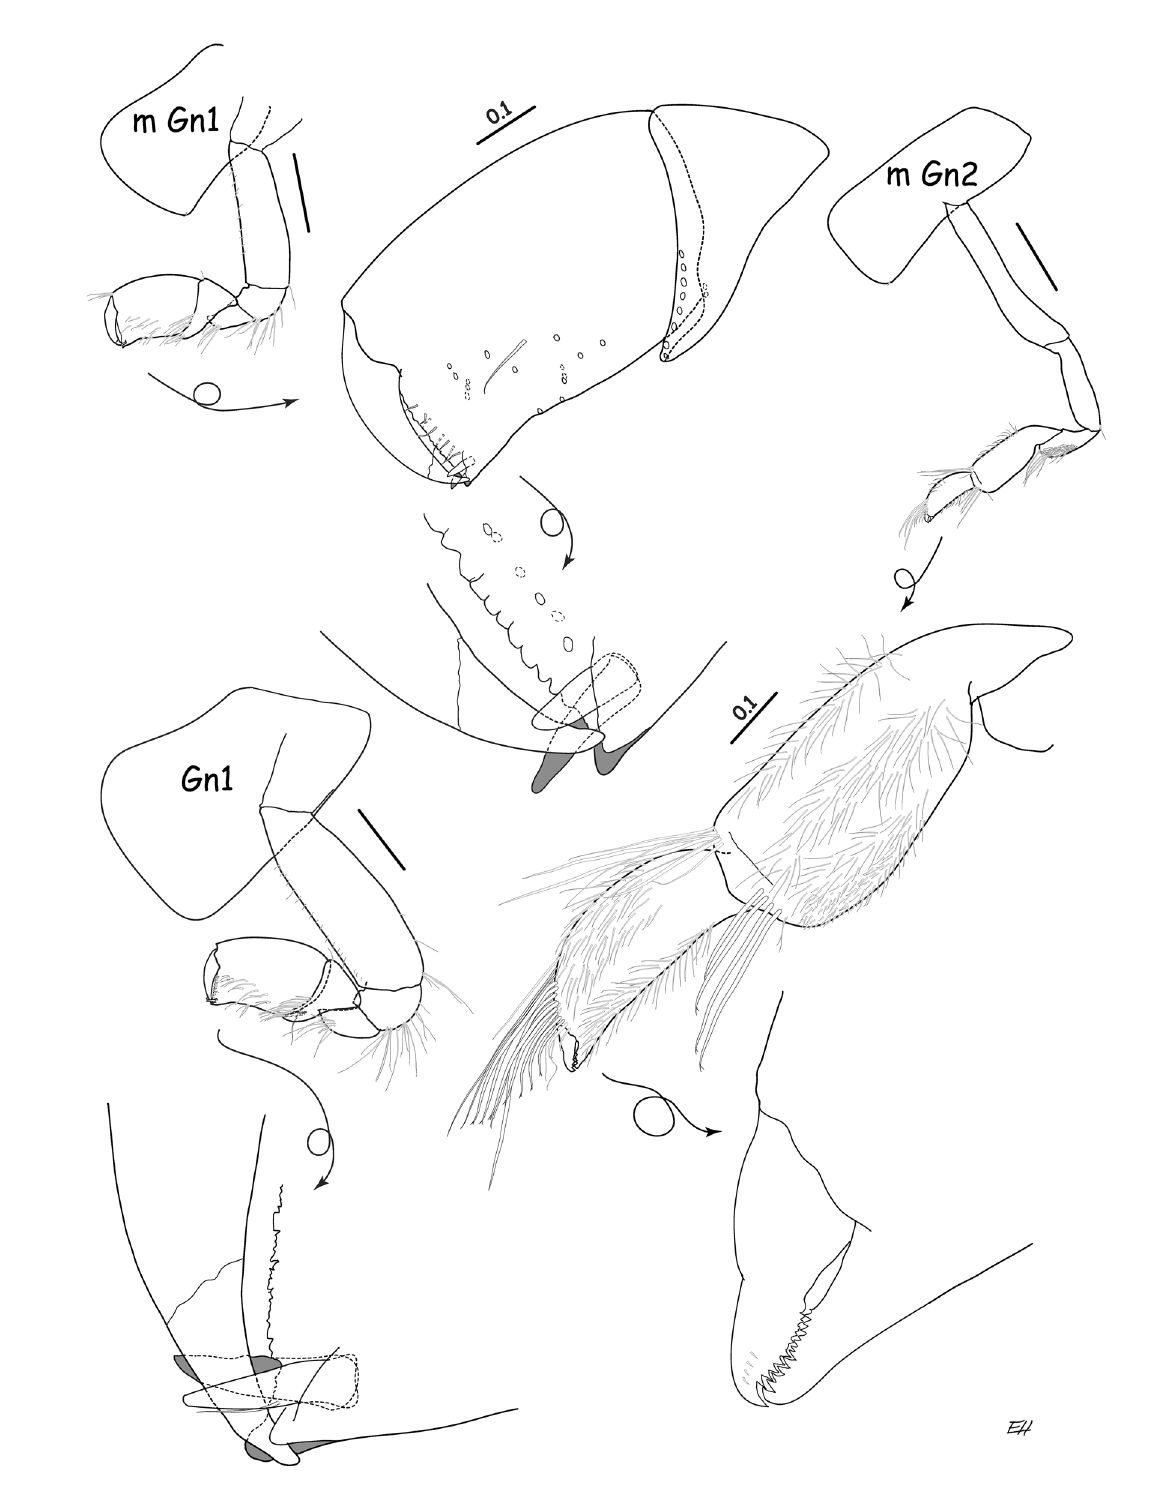
Fig. 14. Abyssorchomene patriciae sp. nov., holotype, ♀, 10.5 mm (NHM UK 2022.6); allotype, ♂, 7.5 mm (NHM UK 2022.7). Setae omitted on Gn1–2 details. Figures with sex not indicated are of female. Scale bars = 0.5 mm unless indicated